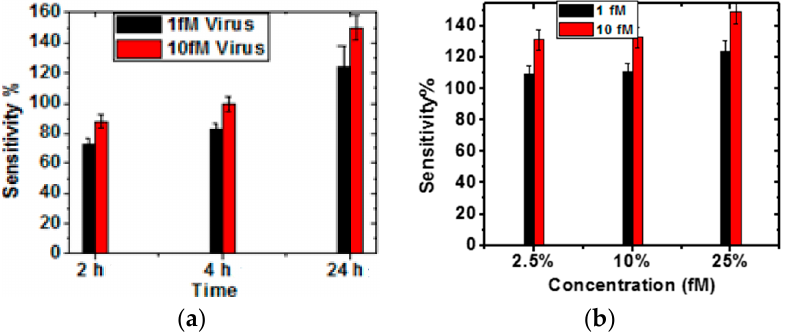
Figure 5. Variation of Sensitivity for different Hep-B concentrations: ( a ) with varying times for 25% glutaraldehyde; ( b ) with different concentrations for 24 h treatment time.